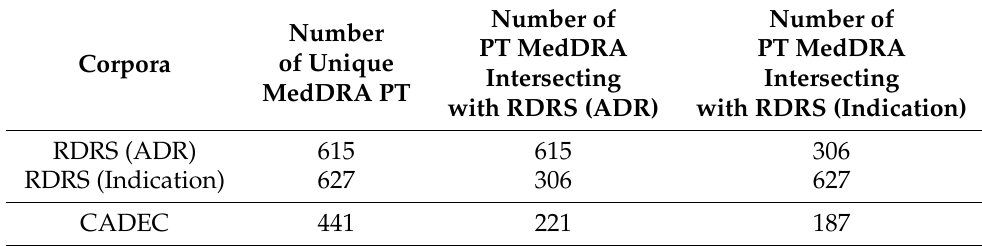
Table 2. Comparison of the CADEC and RDRS datasets on the common PTs set.